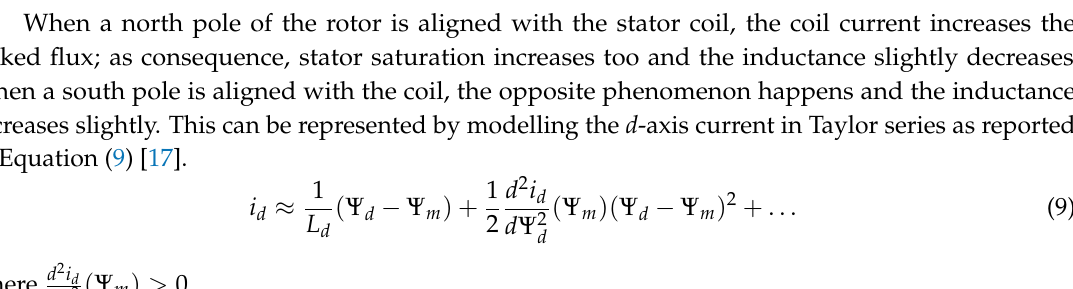
Figure 4. d -axis magnetic saturation